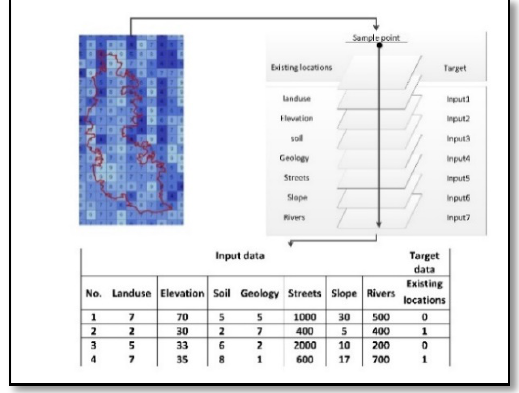
Figure 3. Data extraction